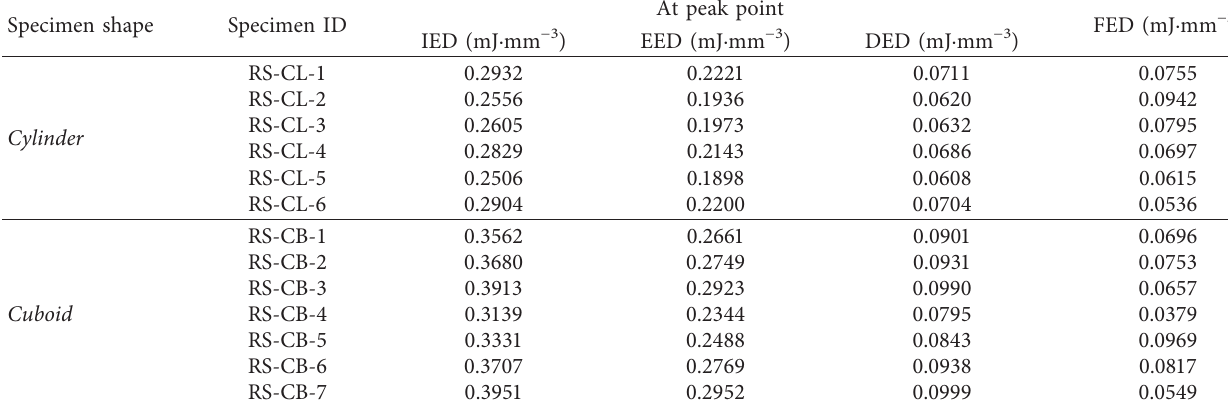
Table 5: Calculations of the energy density.